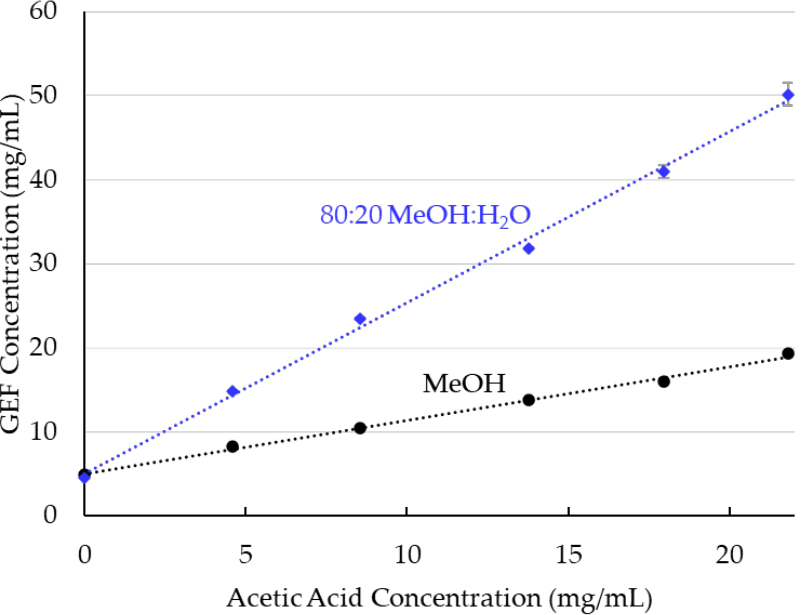
Figure 2. Solubility of GEF in MeOH and 80:20 MeOH:H 2 O as a function of acetic acid concentration. Error in Table In the original publication, there was a mistake in Table 3, as published. The values of the throughput estimates for the gefitinib weight percent solubility, dissolved solids, solvent volume, and spray time were incorrect. The label for the rightmost column also had the incorrect methanol chemical formula, as published. The corrected Table 3 appears